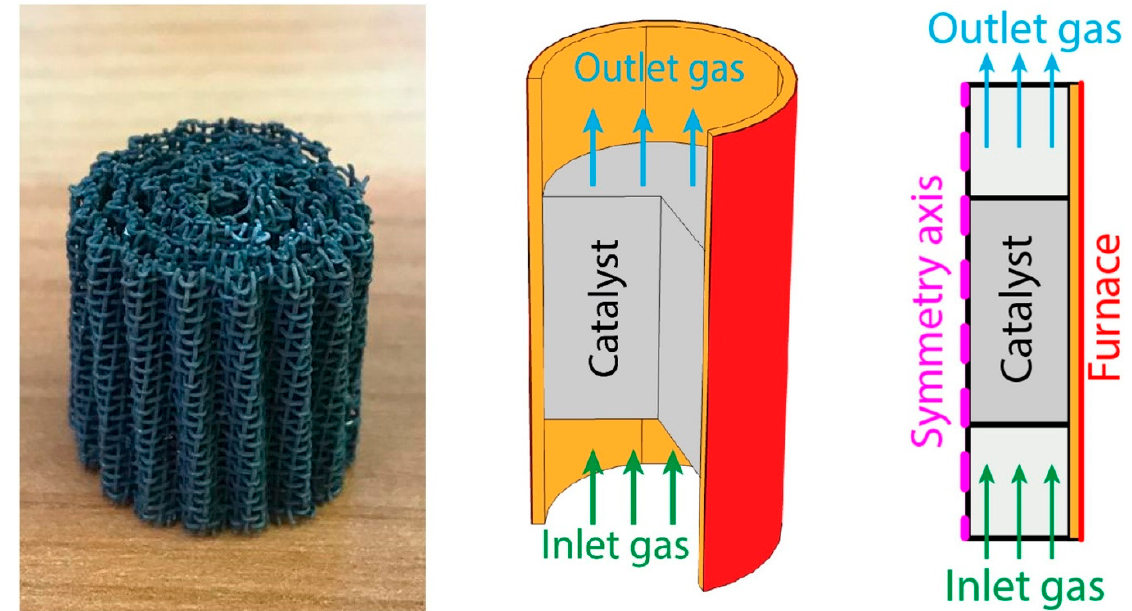
Figure 20. The catalytic block ( left ), considered 3D process geometry ( center ) and 2D axisymmetric computational domain ( right ) [95].